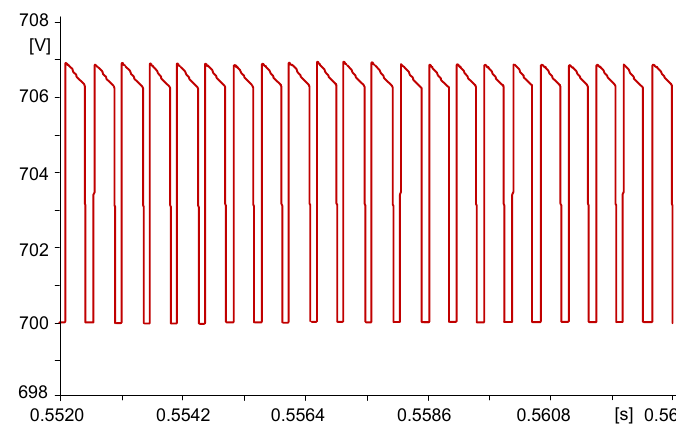
Figure 8. Variation of the current drawn to ground through the capacitance C